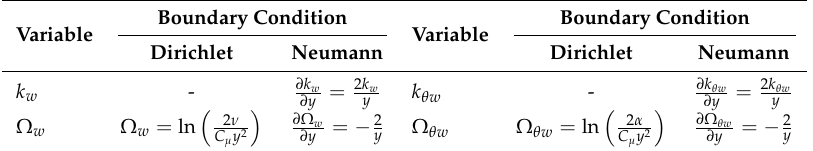
Table 3. Dynamical (on the left) and mixed (MX) thermal boundary conditions for the KLW model [22]. Boundary Condition Variable